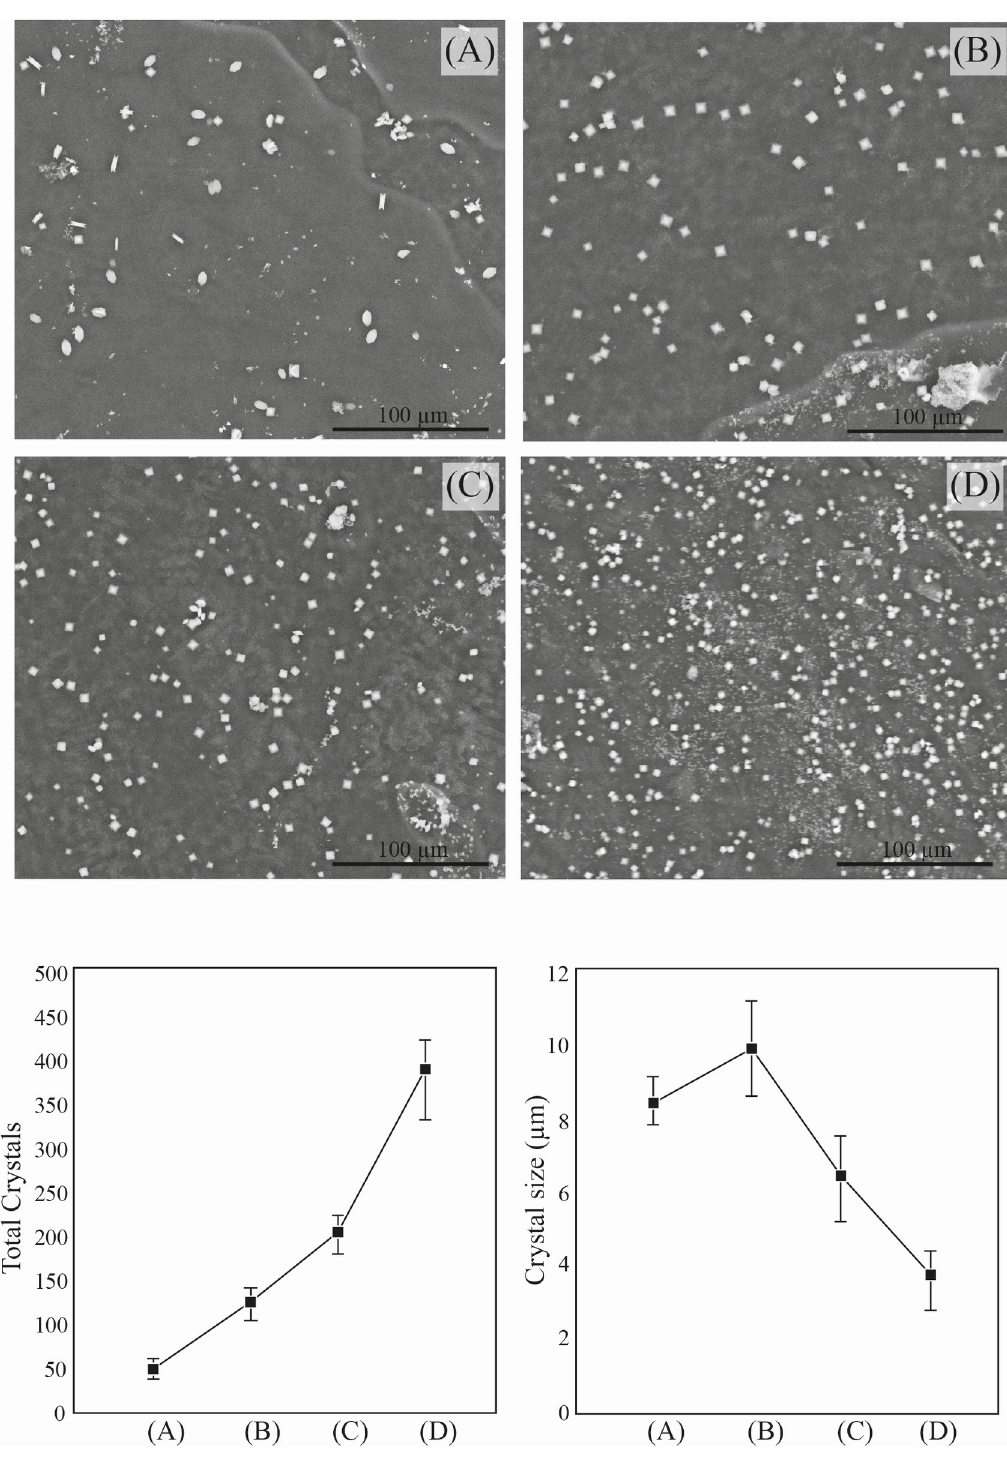
Fig 7. Scanning electron micrographs (upper) and morphometric / numerousness data (lower) of the CaOx crystals obtained in the absence or presence of different concentrations of C . officinarum AE. (A) Control; (B) 200 μ g dw/ml; (C) 500 μ g dw/ml.; (D) 1000 μ g dw/ml of AE.